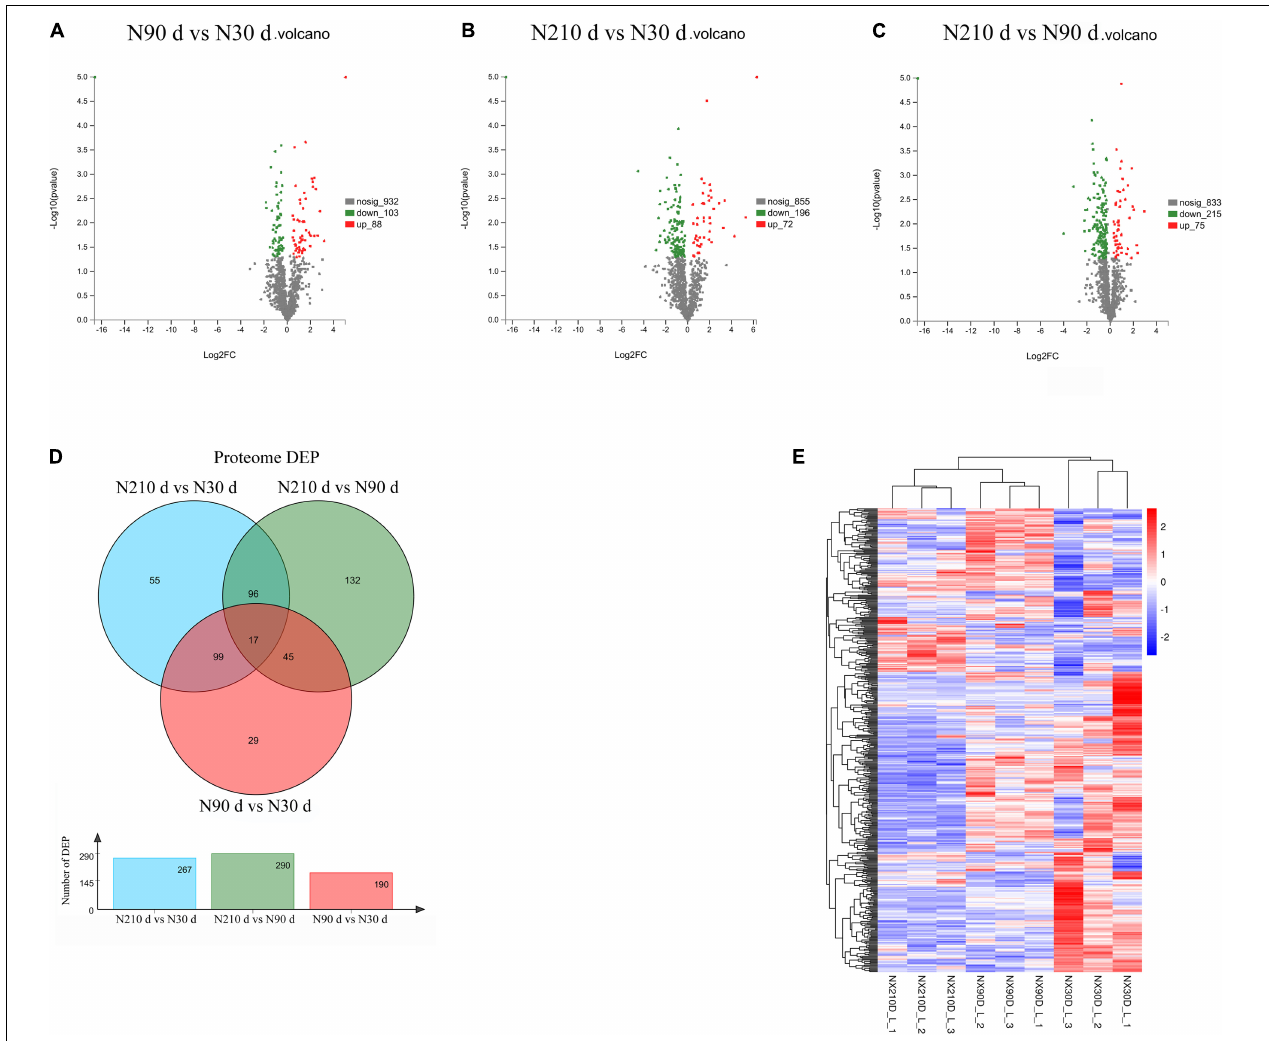
FIGURE 3 | Overview of the differentially expressed proteins. (A–C) Differentially expressed protein between different growth stages in postnatal liver. (D) The Venn diagram of DEPs at three comparison groups. (E) Heatmap of proteins expression abundance at 30, 90, and 210